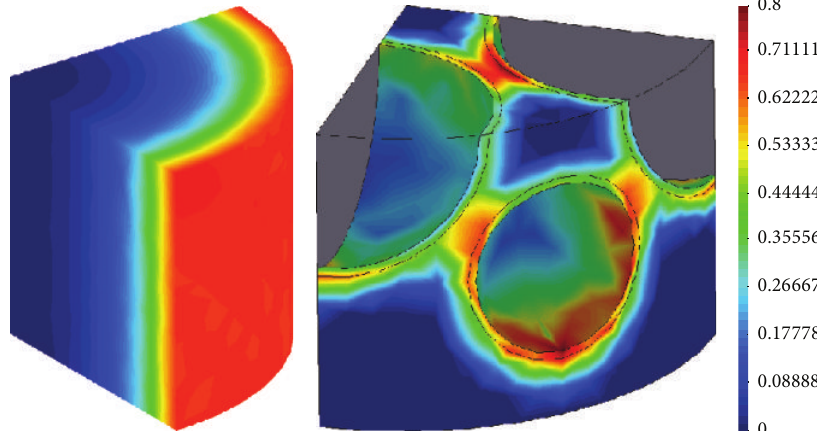
Figure 2: Damage triggering at the macro- and mesoscale level.